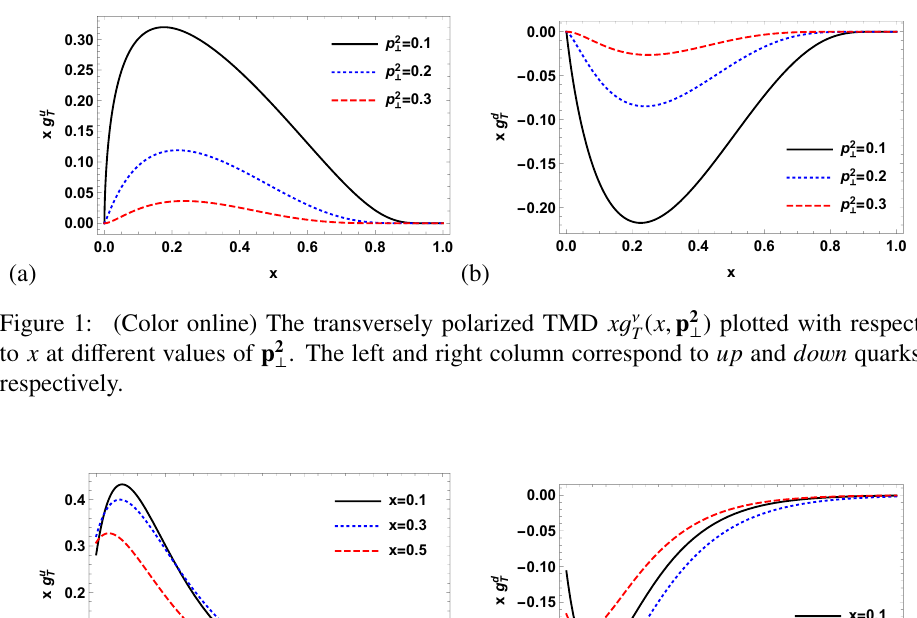
( x , p 2 ) plotted with respect ⊥ T